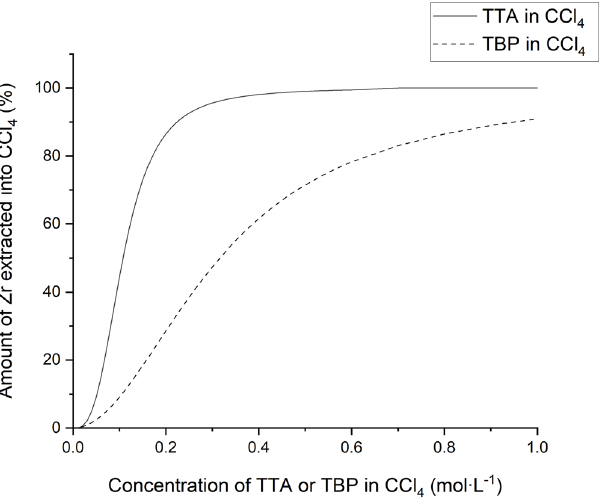
Figure 3. Amount of Zr extracted into CCl 4 as a function of TTA or TBP concentration in CCl 4 from 1 mol·L −1 HNO 3 (TTA) and 5 mol·L −1 HNO 3